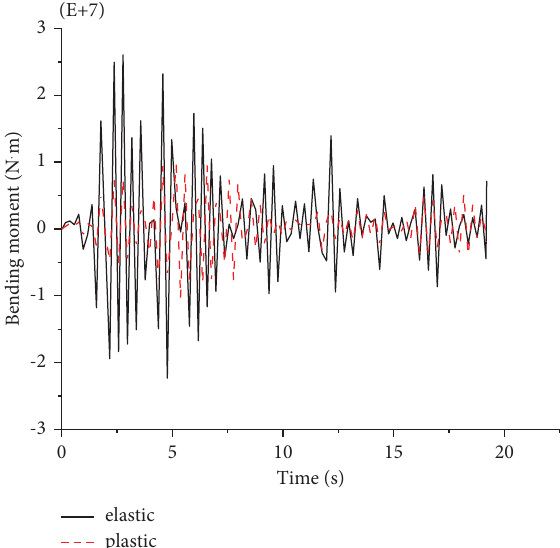
Figure 15: Time - history curve of bending moment in the second span. Table 2: Internal force values of cross sections at diferent positions. Second straddle in Tird straddle in Pier top First straddle in middle middle Elastic Elastoplastic Elastic Elastoplastic Elastic Elastoplastic